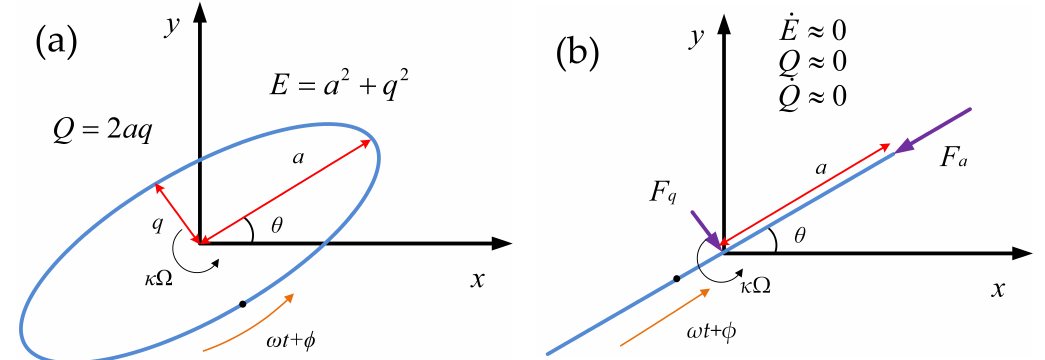
Figure 3. Illustration of the vibration pattern of an gyroscope in Whole-Angle mode. ( a ) The general vibration state and ( b ) the vibration state under